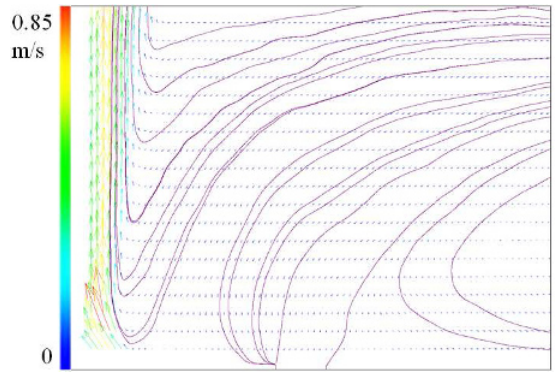
Fig. 8. The flow from the convector for the wall temperature 12.5 °C. The size of the displayed area was 630x480 mm. of the wall cooling is insignificant in the measured